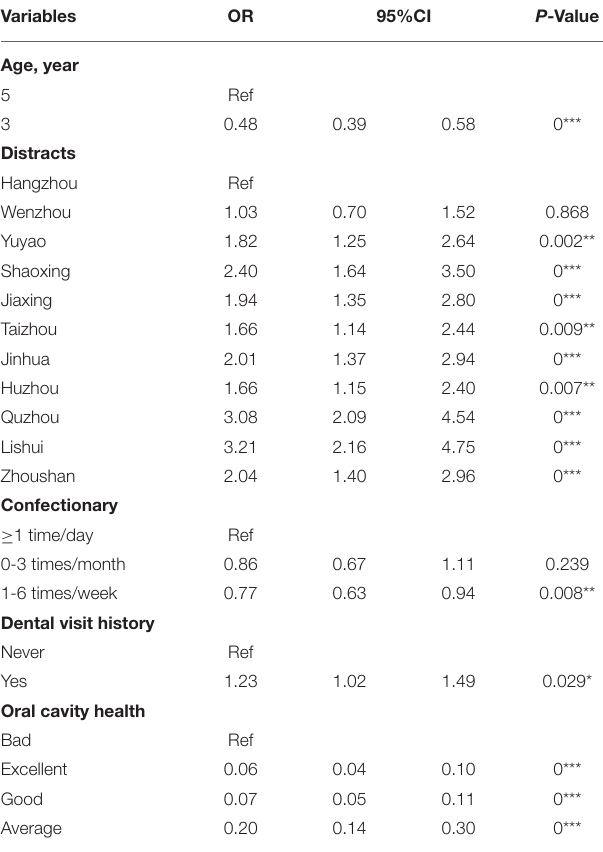
TABLE 5 | Association of relevant variables with ECC, using multiple logistic regression model.